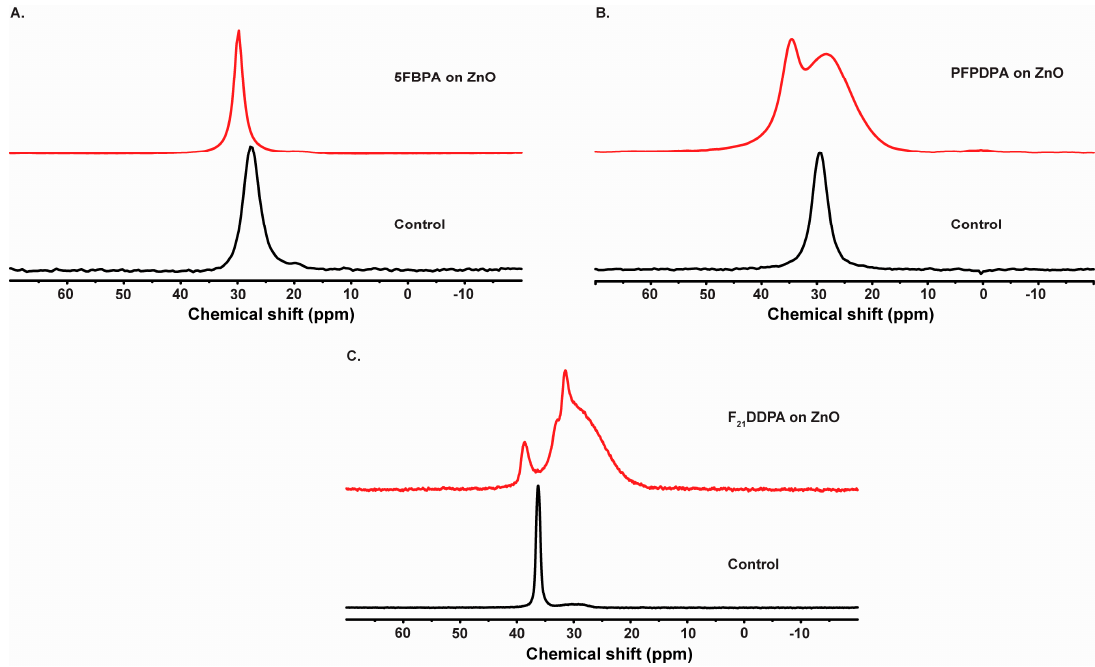
Figure 4. Solid-state 31 P CP-MAS NMR spectra of ( A ) 5FBPA; ( B ) PFPDPA; and ( C ) F 21 DDPA modifications and bulk controls.